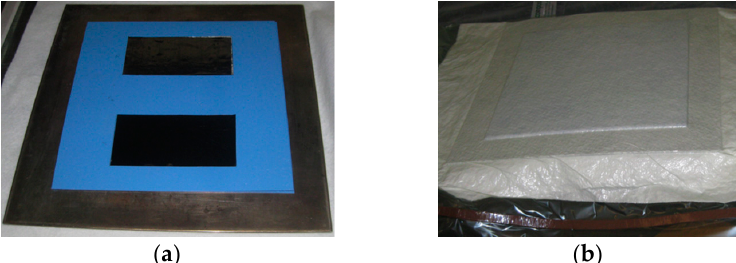
Figure 6. Bistable laminates manufacturing: ( a ) Hexply 8552 prepregs on the mold and ( b ) vacuum bag.